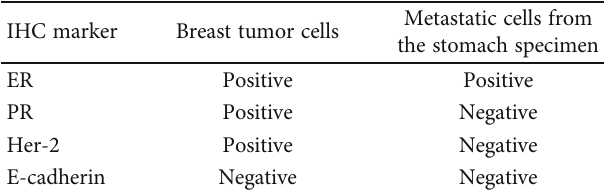
Table 1: Immunopro fi le comparison of the tumor cells in the primary vs. metastatic